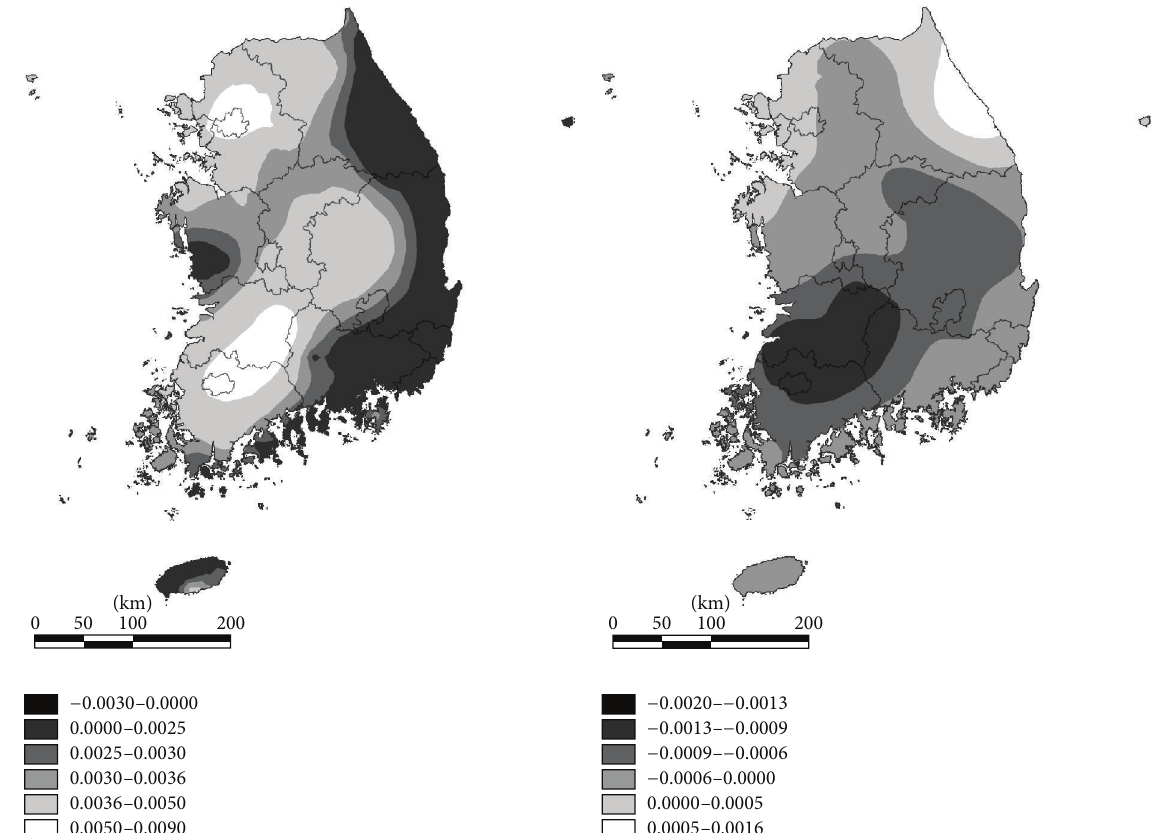
Figure 9: Map of the linear trend of 1-hour precipitation statistics of